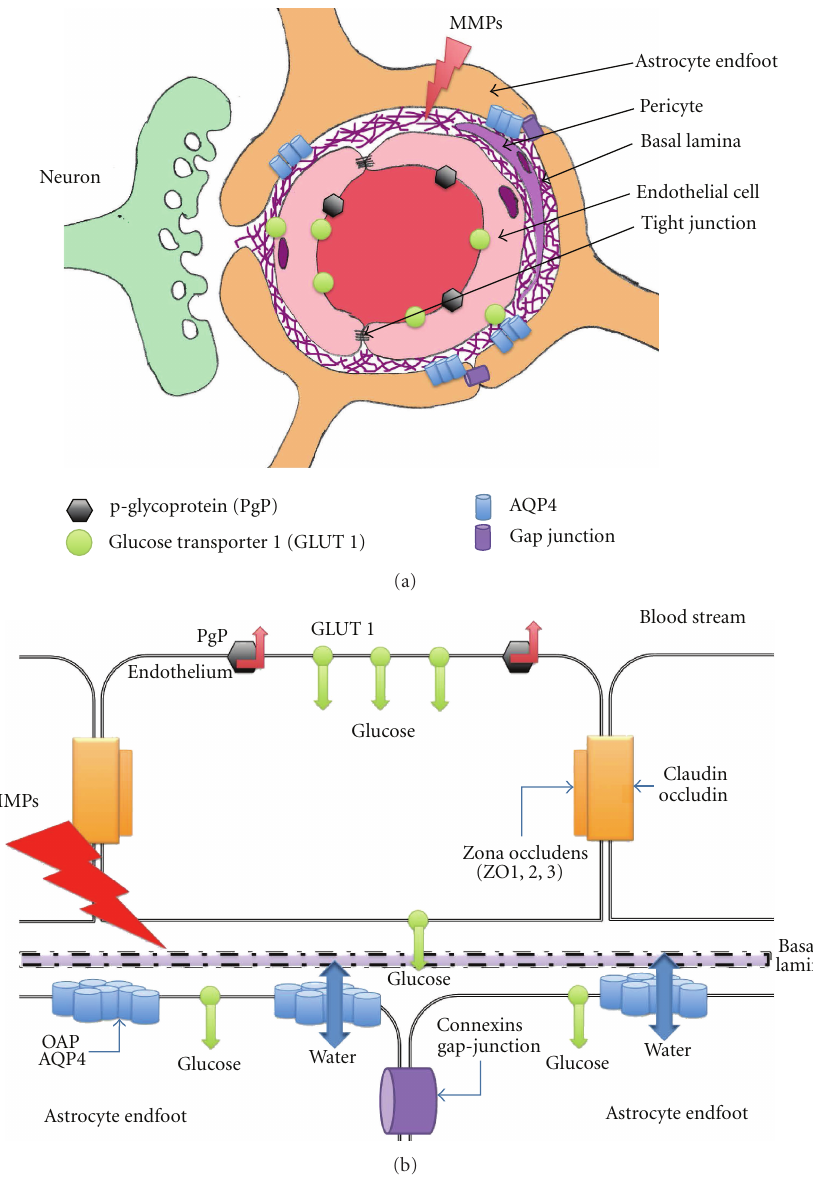
Figure 1: (a) Schematic drawing of the neurovascular unit (NVU) in the capillary bed composed by the neuron, astrocyte endfoot, basal lamina, pericyte, and endothelial cell. The endothelial cell is the first barrier between the blood stream and the nervous tissue. The presence of the tight junction composes the physical barrier and the movement of substrates is controlled by several transporters. The astrocyte endfeet are linked with the gap junction, allowing movement of several solutes in the astrocyte network. The basal lamina is composed of several proteins such as agrin, dystroglycan, and perlecan. (b) A close-up schematic drawing of the endothelial cells and astrocyte endfeet with some of the proteins involved in edema formation and